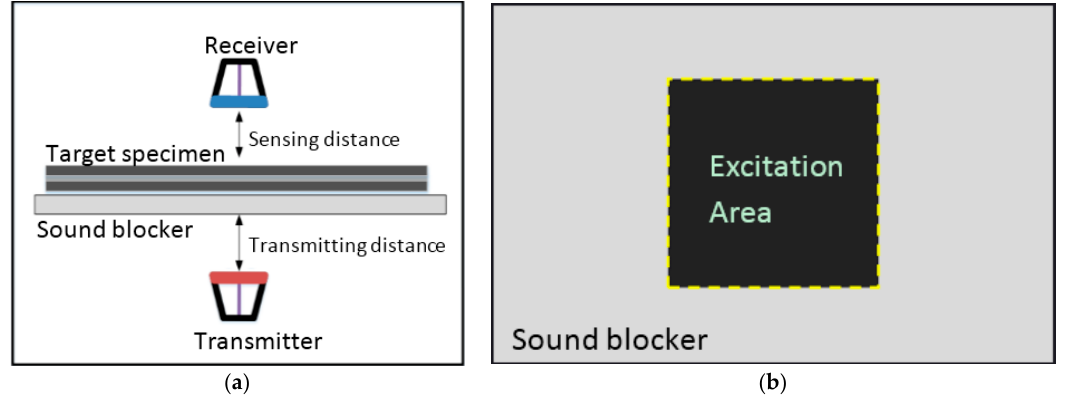
Figure 6. Details of the schematic experimental configuration for the adhesive bonded aluminum plate: ( a ) through transmission configuration for debonding detection; and ( b ) bottom view of the sound blocker. The excitation area denotes a hole for transmitting the ultrasonic wave to the target specimen.